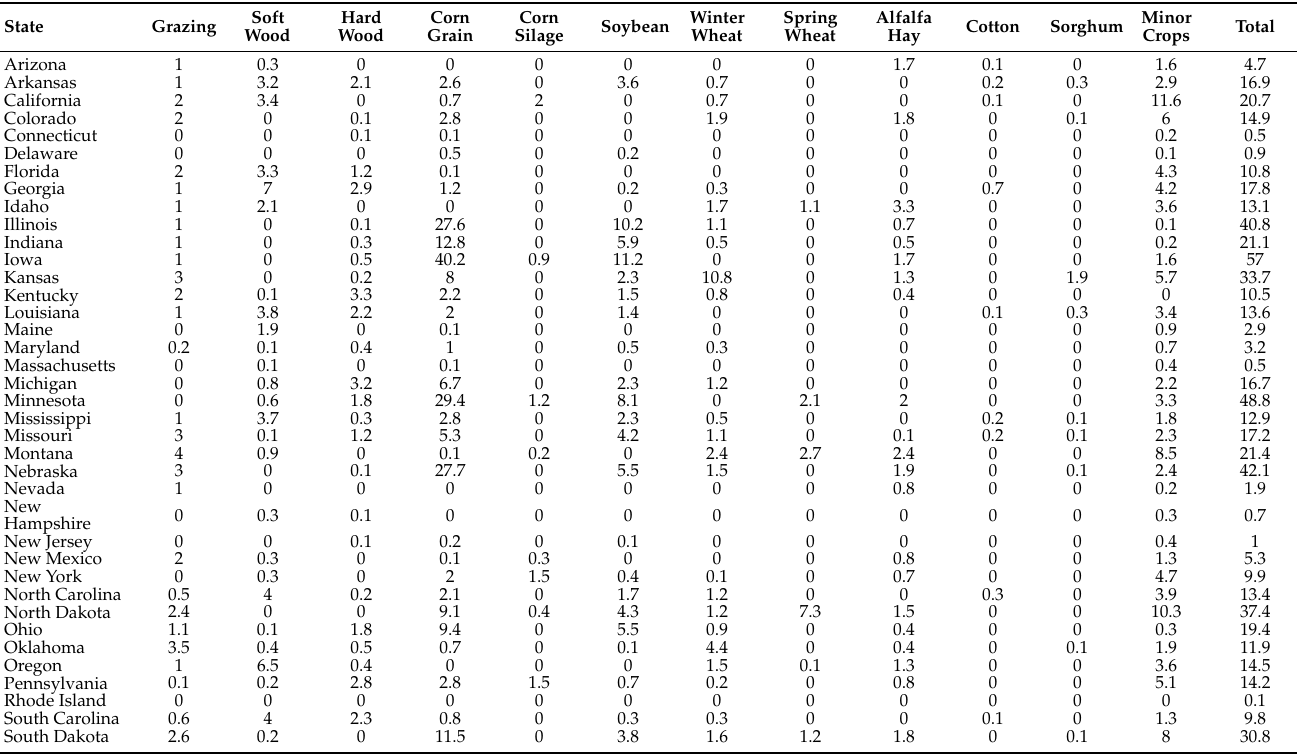
Table A1. HANPP in megatons (MT) in 48 contiguous states in 2012 for specific products. Source of data: